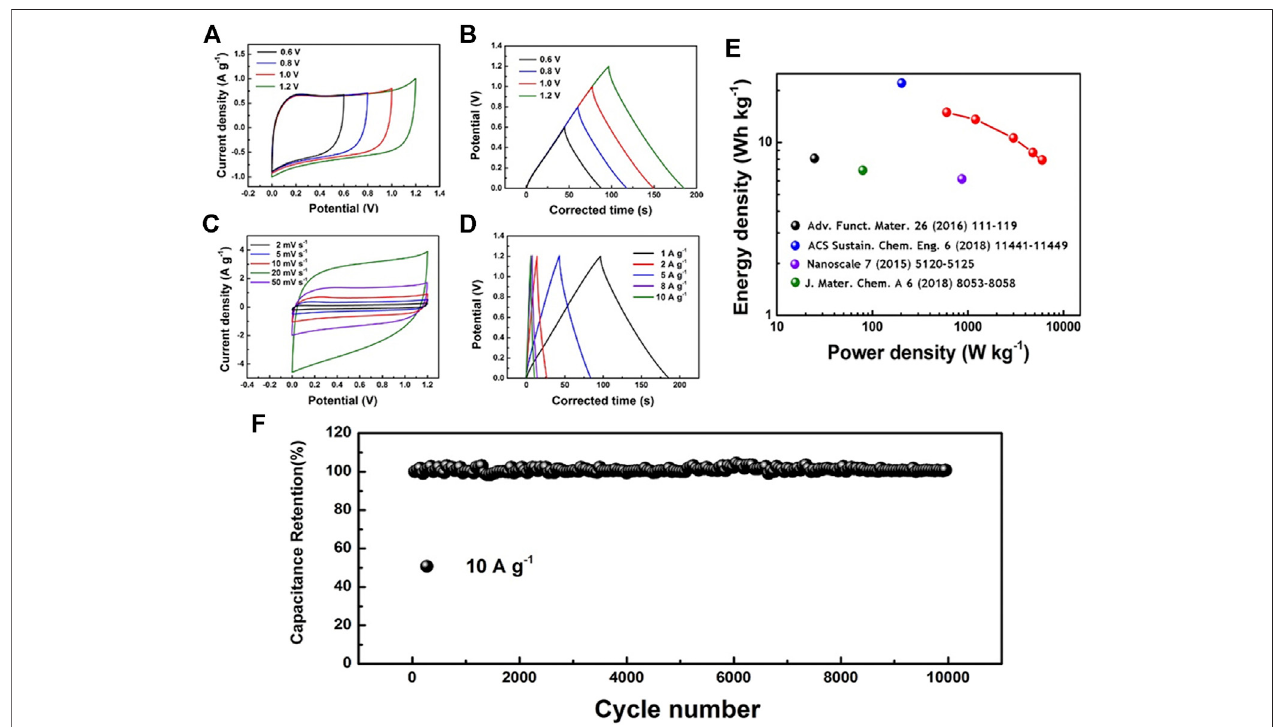
FIGURE 8 | Electrochemical performances of BN-CCF based symmetrical SCs: (A) CV curves (10 mV s − 1 ) and (B) GCD curves (1 A g − 1 ) in 0.6 – 1.2 V (C) CV curves at different scan rates and (D) GCD curves at various current densities in a voltage window of 0 – 1.2 V (E) Ragone plots and (F) Cycling performance of BN-CCF based symmetrical